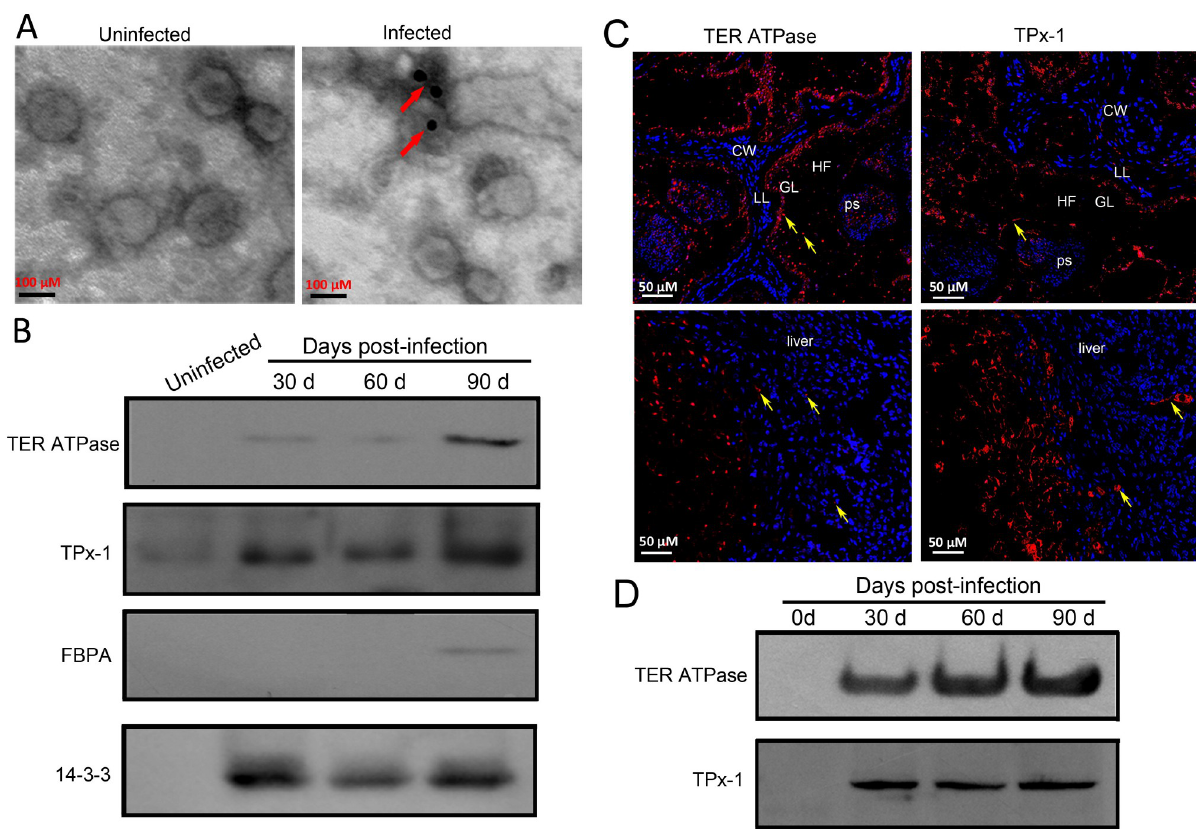
Fig 2. Parasite-origin protein components in serum-derived exosomes in response to E . multilocularis infection. (A) Immune electron microscopy of EVs isolated from the sera of E . multilocularis -infected and uninfected mice using anti-Em14-3-3 antibodies. The red arrows indicated the parasite- derived EVs. (B) Western blotting analysis of TPx-1, TER ATPase, and FBPA in the serum-derived exosomes at 30- , 60- , 90-day post infection . The uninfected mouse sera were used as control. (C) Immunofluorescence localization of TER ATPase and TPx-1 in the E . multilocularis-infected mouse liver. CW, cyst wall; GL, germinal layer; HF, hydatid fluid; LL, laminated layer; ps, protoscolexs; liver, mouse liver. The nucleus was stained by DAPI. Localization of TER ATPase or TPx-1 was indicated by yellow arrows. (D) T he recombinant TPx-1 and TER ATPase could recognize by E .